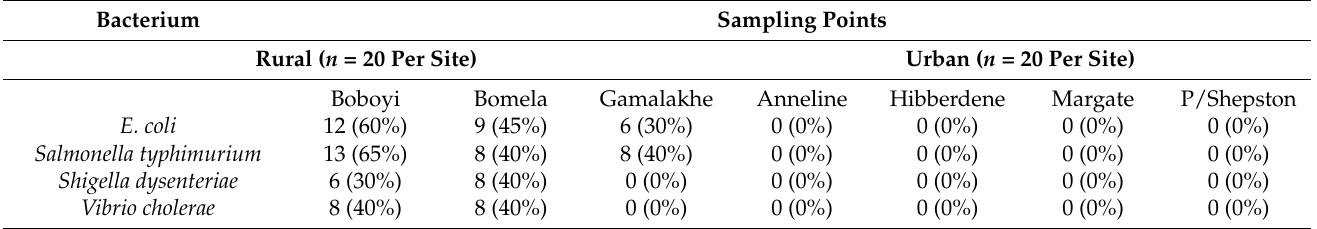
Table 4. Detection of target bacterial pathogens in drinking water samples by species-specific PCR.